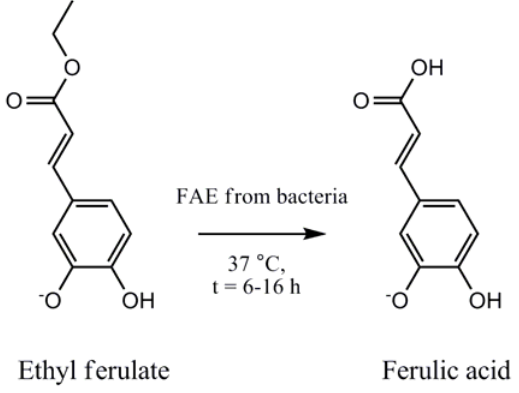
Figure 1 . Ferulic acid esterases (FAE) enable microbes to hydrolyse the ester bond between hydroxyl cinnamic acids and sugars. The hydrolysis of ethyl ferulate by FAE gives rise to ferulic acid a compound with a number of health-promoting